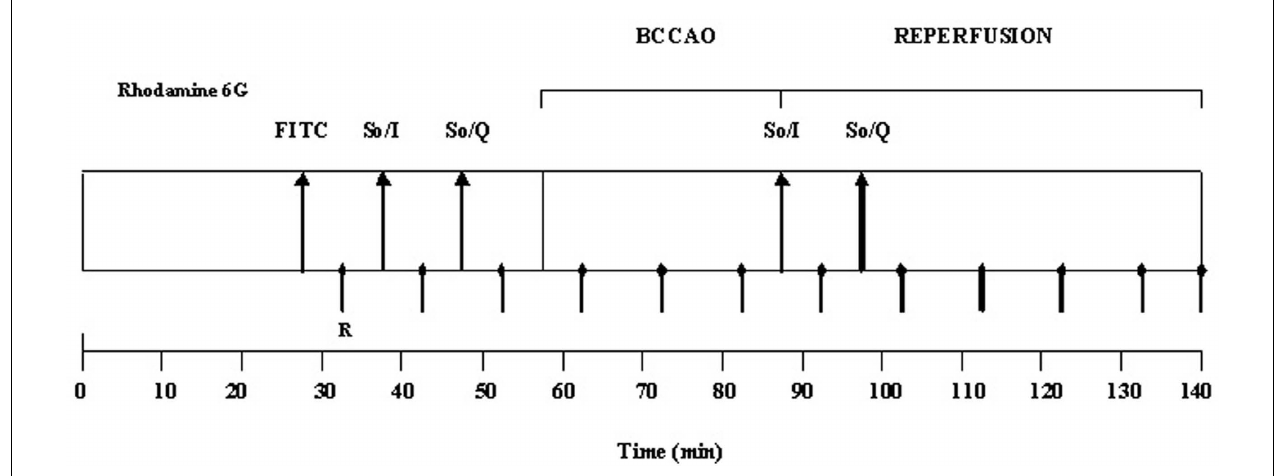
So/Q: solvent, 0.9% NaCl, and/or quercetin administration. BCCAO: bilateral common carotid artery occlusion. Rhodamine 6G was injected after FITC-dextran as a bolus and then infused during BCCAO and